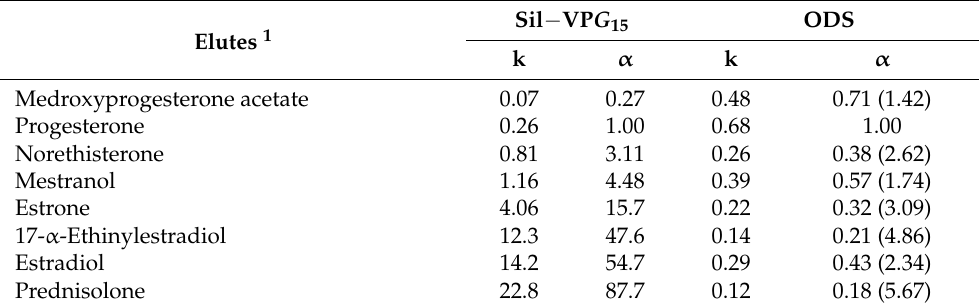
Table 4. Retention factors (k) and separation factors ( α ) of steroids using Sil − VP G 15 and ODS. Elutes